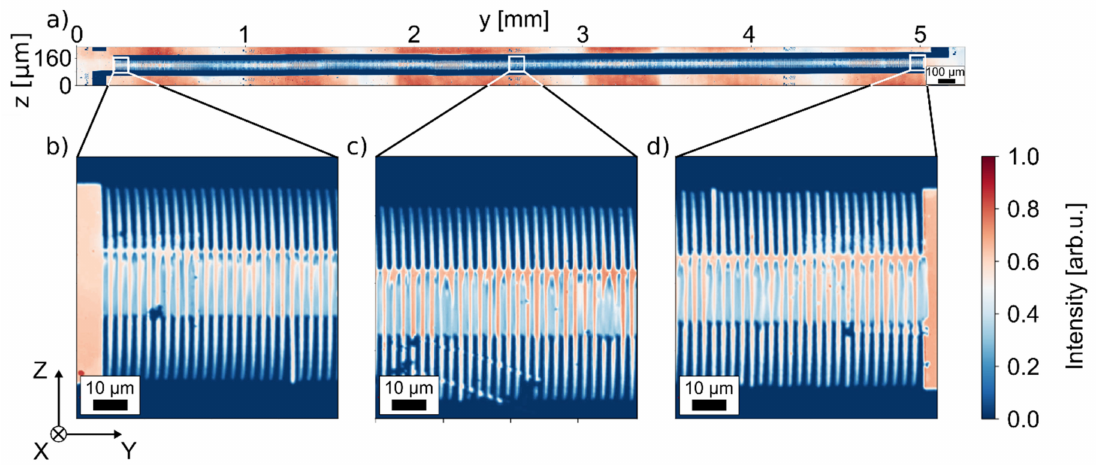
Figure 8. Large-scale SHG imaging of the complete, 5-mm-long PP-TFLN sample. ( a ) Overview micrograph obtained by stitching 20 individual measurements together. ( b – d ) Detailed high-resolution scans at different locations along the waveguide